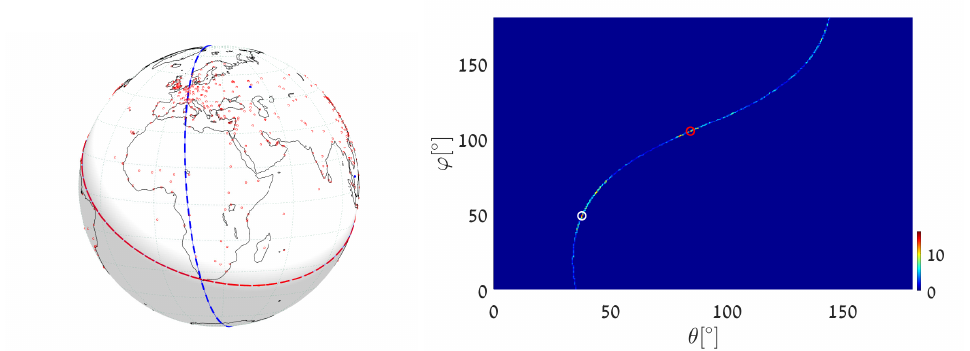
Figure 18. Executing Algorithm 1 on the city database. ( Left ) The blue great circle passes through the maximum number of cities (red dots). The red circle corresponds to the second maximum, following the unvoting process. ( Right ) Heat plot of the accumulator array M , showing the parameters of the two great circles.